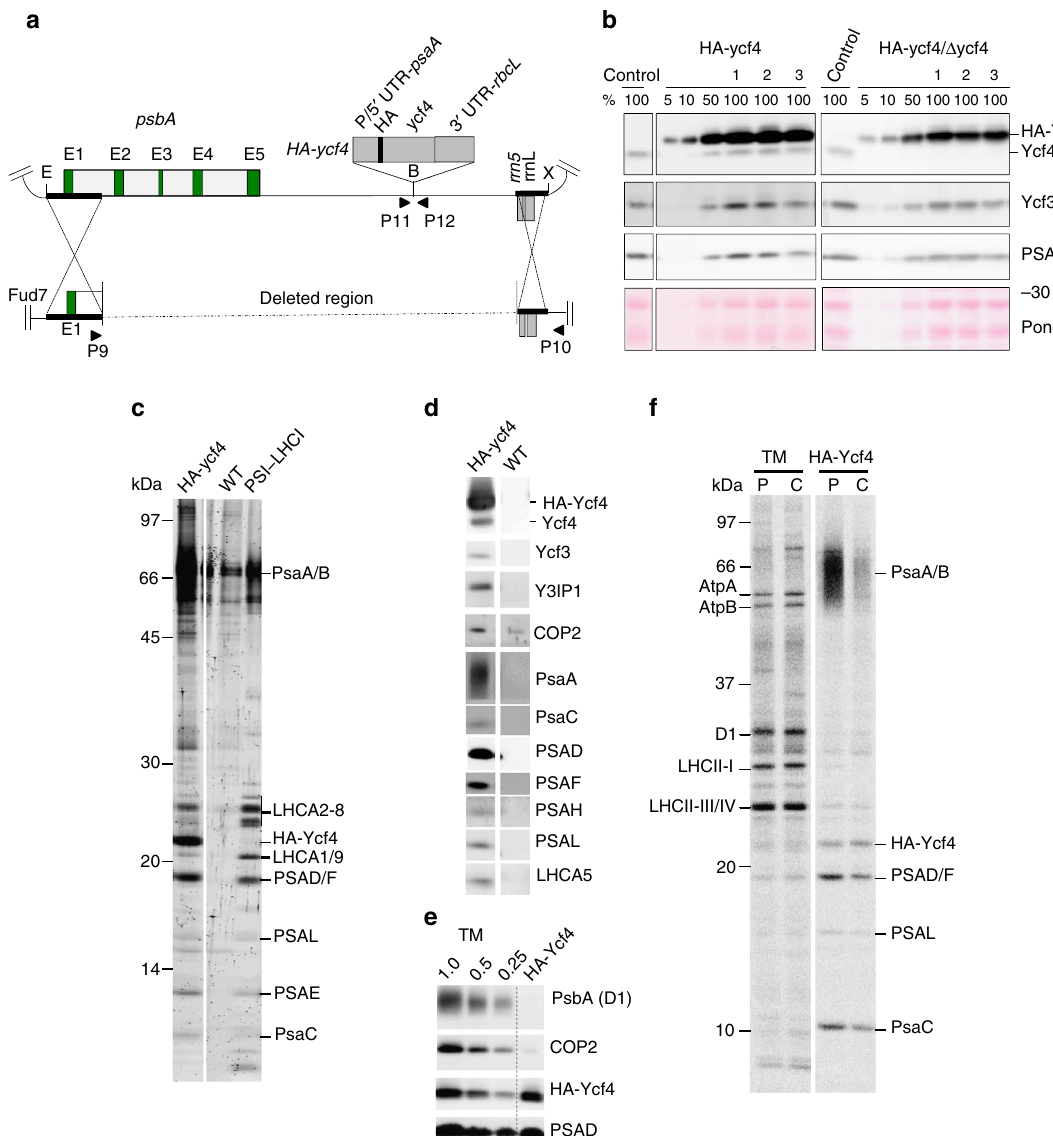
Fig. 4 HA-Ycf4 transiently associates with newly synthesized PSI core subunits. a Physical map of the vector containing HA-ycf4 expression cassette inserted at the Bam HI site downstream of the psbA gene is shown. The ycf4 cassette contains the coding sequence of HA tag and ycf4 fl anked by P/5 ′ -UTR of psaA and 3 ′ -UTR of rbcL . HA-Ycf4 contains HA tag inserted at N-terminus of Ycf4. E, X, and B depict restriction sites for Eco RI, Xho I, and Bam HI, respectively. P9/P10 and P11/P12 represent pairs of primers used for PCR (Supplementary Fig. 3a). b The expression of HA-Ycf4 was con fi rmed by immunoblotting. Total cellular proteins from control, HA-ycf4 (clones 1 – 3), and HA-ycf4/ Δ ycf4 (clones 1 – 3) mutants grown under photoheterotrophic condition were analyzed. The nitrocellulose membrane was stained with Ponceau for loading control. c Polypeptide compositions of the af fi nity-puri fi ed preparations from HA-ycf4 and WT strains. The puri fi ed PSI – LHCI was loaded as a reference. Polypeptides separated by SDS-PAGE were visualized by staining with Flamingo. d Polypeptide compositions detected by immunoblotting. e Estimation of enrichment of COP2 in the HA-Ycf4 preparation. Dilution series of thylakoid membranes (TM) corresponding to 1.0, 0.5, and 0.25 μ g Chls per lane were loaded to estimate the abundance of D1, COP2, HA-Ycf4, and PSAD in the HA-Ycf4 preparation by immunoblotting. f Pulse-chase labeling of proteins with 35 S. Cells were pulse-labeled for 10 min (P) and then were chased for 6 h (C). TM; the puri fi ed thylakoid membranes, HA-Ycf4; the af fi nity-puri fi ed HA-Ycf4 more in HA-ycf4 and HA-ycf4/ Δ ycf4 double mutants than that of the endogenous Ycf4 in the control strain (Fig. 4b). The HA-ycf4 mutant accumulated Ycf3 and PSAF as well as the endogenous Ycf4 at normal levels (Fig. 4b) and showed PSI activity and photoautotrophic growth (Supplementary Fig. 3b, c), indicating that the over-expression of HA-Ycf4 had no deteriorating effect on functional assembly of PSI complex. The HA-ycf4/ Δ ycf4 mutant also accumulated PSI and grew photosynthetically similar to control strain (Fig. 4b, Supplementary Fig. 3b, c), indicating